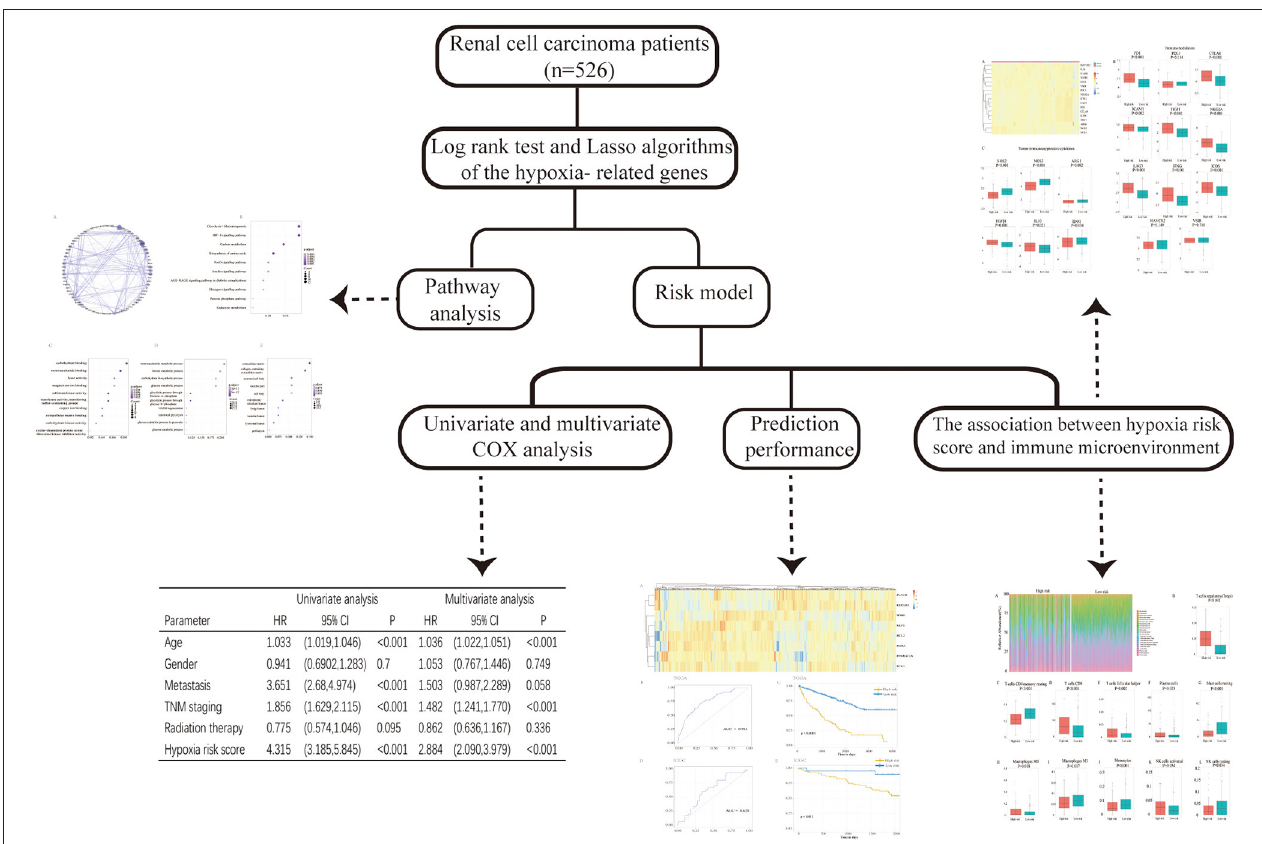
FIGURE 1 | The flowchart of the